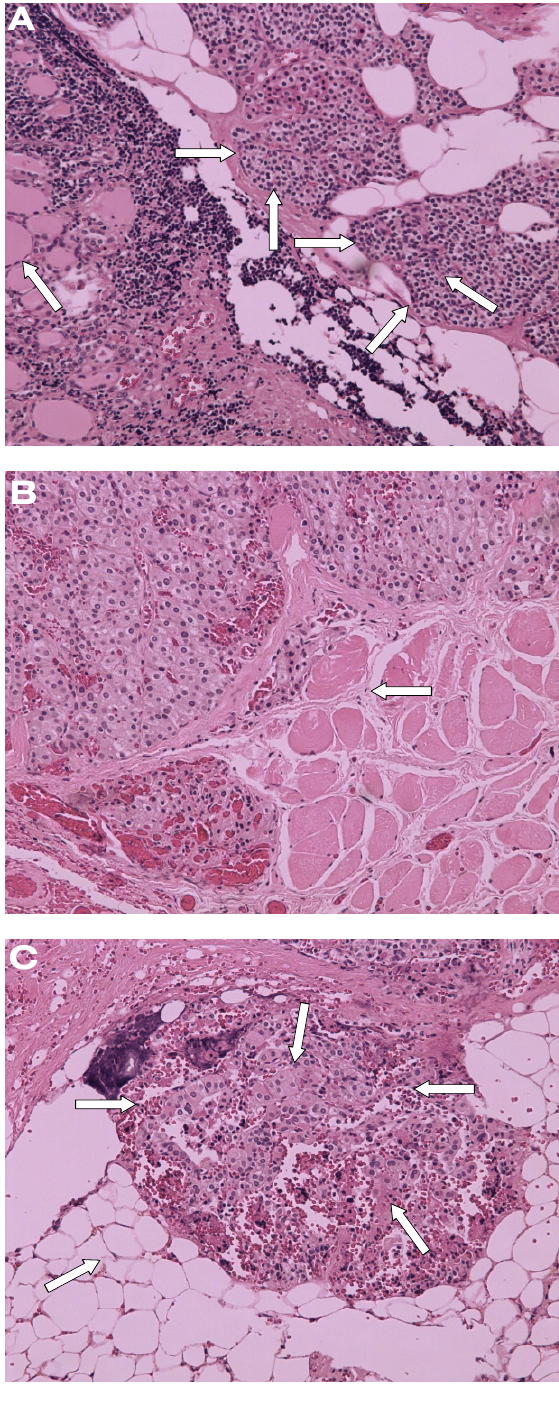
Figure 3. A Parathyroid gland cells (arrows) in surrounding tissues, thyroid gland (arrow). B Parathyroid gland cells (arrows) in neck muscles (arrow). C Parathyroid gland cells (arrows) in fatty tissues